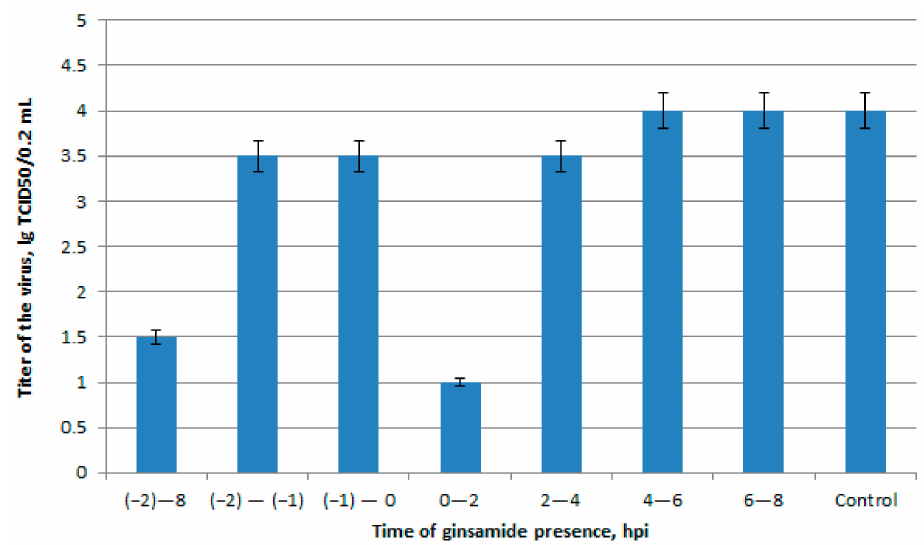
Figure 4. Activity of ginsamide (GS) against influenza virus A/Puerto Rico/8/34 (H1N1) according to the time-of-addition experiment. MDCK cells were infected with influenza virus, and GS (200 µ M) was added at the indicated time points, where 0 corresponds to the moment when the cells were infected.